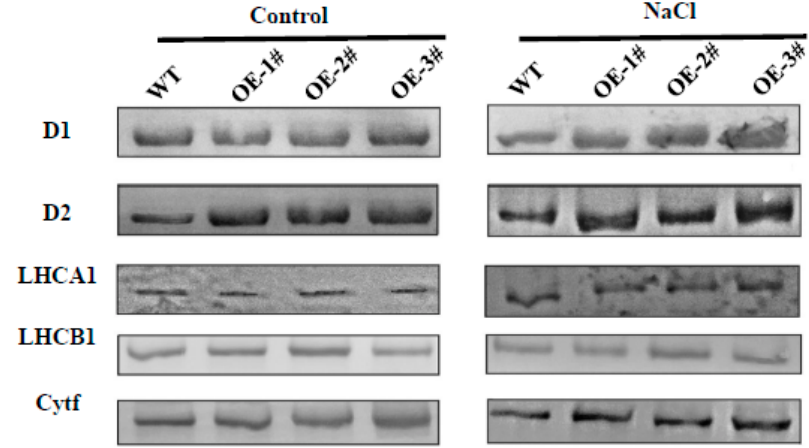
Figure 11. Analysis of thylakoid membrane protein changes in WT and CsTGase OE plants under salt stress. Thylakoid membrane proteins were separated by 12% SDS-urea-PAGE, transferred to PVDF membranes and probed with antisera against known thylakoid membrane proteins obtained from Agrisera company.